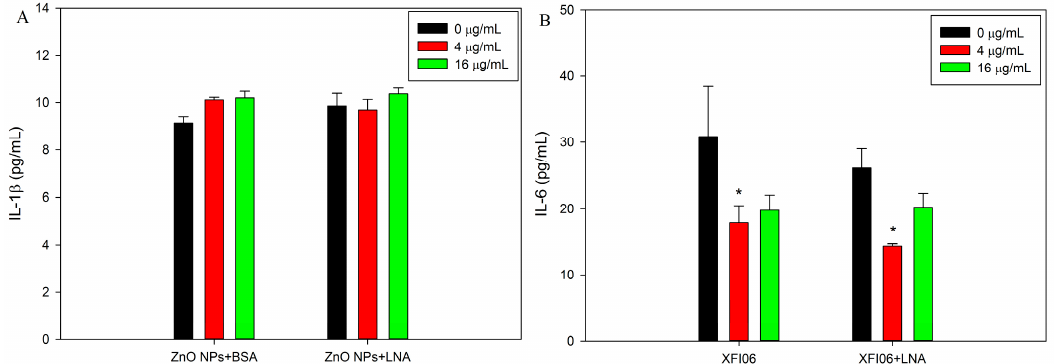
Figure 10. The release of inflammatory cytokines interleukin-1 β (IL-1 β ; ( A )) or IL-6 ( B ). HepG2 cells were exposed to various concentrations of ZnO NPs (code: XFI06) with the presence of bovine serum albumin (BSA) or α -linolenic acid (LNA; complexed to BSA; referred to as LNA) for 24 h, and the release of IL-1 β and IL-6 was measured by ELISA. * p < 0.05, ANOVA, compared with control.